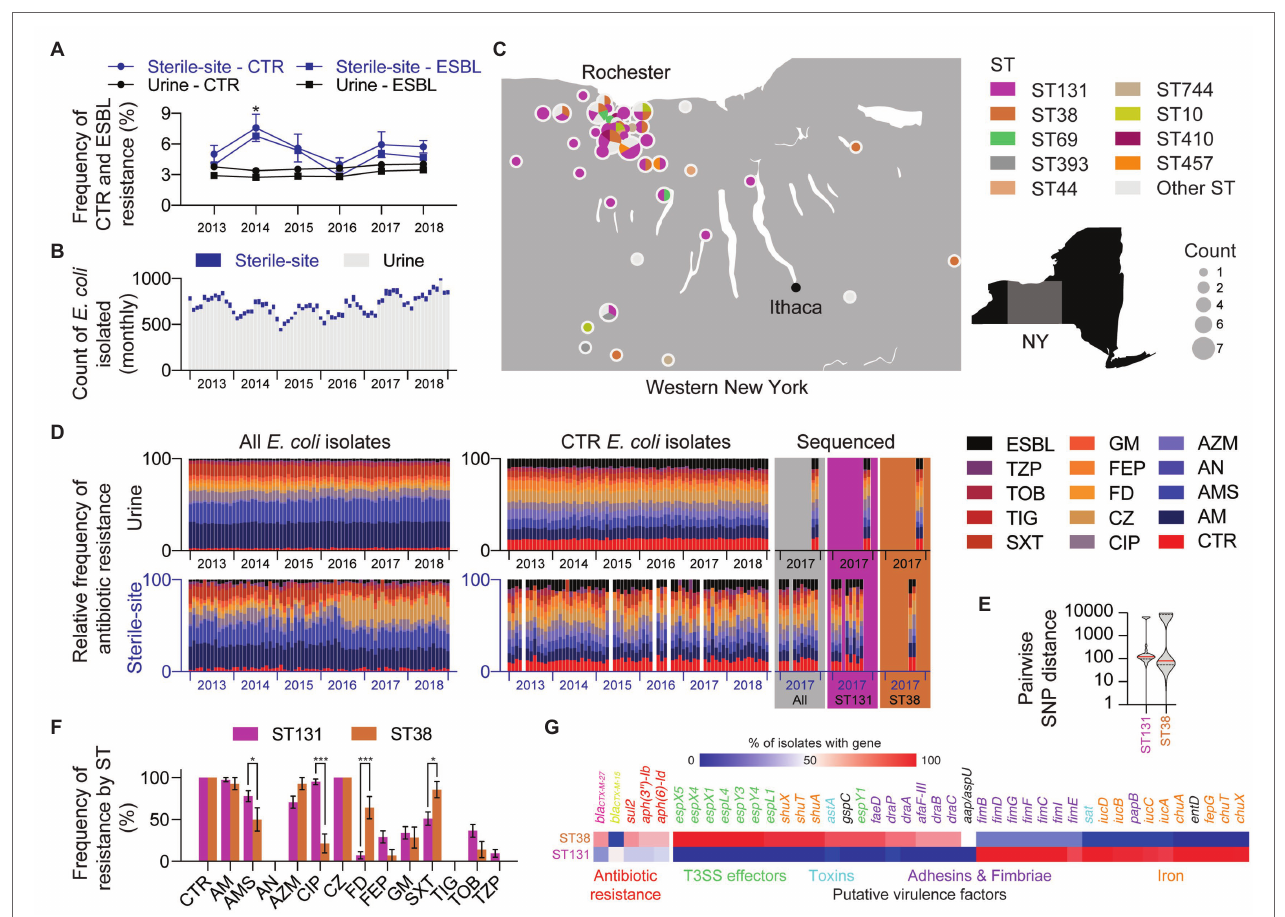
FIGURE 1 | Incidence of ceftriaxone-resistant (CTR) and extended-spectrum β -lactamase (ESBL)-producing Escherichia coli in Western New York (NY). (A) Yearly frequency of CTR and ESBL-producing E. coli in sterile-site and urine E. coli . Mean percentage with error bars showing SEM. Statistical test: t -test (Holm-Sidak method). Significance: * p ≤ 0.05. (B) Total monthly count of sterile-site and urine E. coli isolated between 2013 and 2018. Data include only one isolate per patient. (C) Geographic distribution and prevalence of E. coli sequence types (STs). (D) Antimicrobial resistance (AMR) profiles of sterile-site and urine E. coli isolated between 2013 and 2018. Relative frequency is shown for monthly profiles for all isolates (left) , CTR isolates (right) , and whole-genome sequenced (WGS) CTR isolates (colored panels). CTR, ceftriaxone; AM, ampicillin; AMS, ampicillin-sulbactam; AN, amikacin; AZM, aztreonam; CIP, ciprofloxacin; CZ, ceftizoxime; FD, nitrofurantoin; FEP, cefepime; GM, gentamicin; SXT, trimethoprim-sulfamethoxazole; TIG, tigecycline; TOB, tobramycin; TZP, piperacillin-tazobactam; ESBL, Extended spectrum β -lactamase. (E) Violin plot showing distribution of intraclade pairwise SNP distances for ST131 and ST38. (F) Differences in AMR rates between sterile-site and urine E. coli ST131 and ST38 STs. Statistical test: multiple t -tests (Holm-Sidak method). Significance: * p ≤ 0.05 and *** p ≤ 0.001. (G) ARGs and putative virulence factors associated with ST131 and ST38. Color indicates percentage of ST131 or ST38 isolates encoding genes listed. Genes are listed only if mean ST131 and ST38 percentages differ by >30% (for ARGs) and >50% (for putative virulence